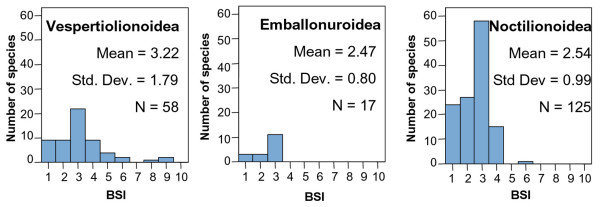
BSI Histograms of Chiroptera superfamilies.